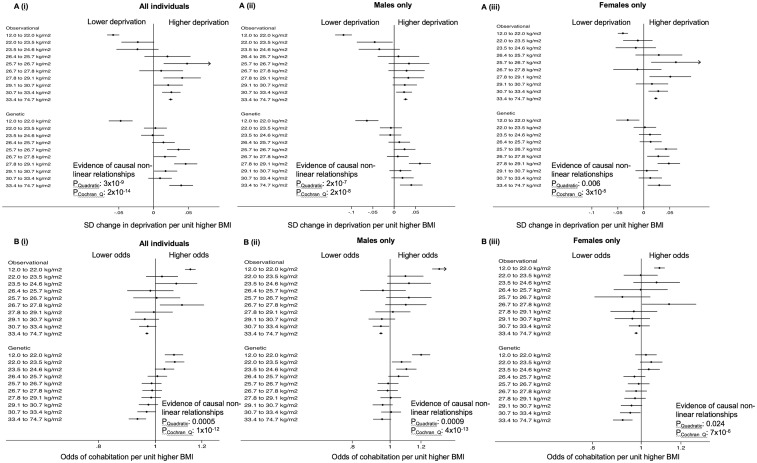
Dot plot exploring the non-linear associations of BMI with TDI and cohabitation, in deciles of genetically-determined BMI using the piecewise linear model from non-linear MR analysis. The P-values presented for causal non-linear relationships are from the piecewise linear model (PQuadratic and PCochran Q). Full results of non-linear analyses are provided in Supplementary Tables S8 and S9, available as Supplementary data at IJE online.